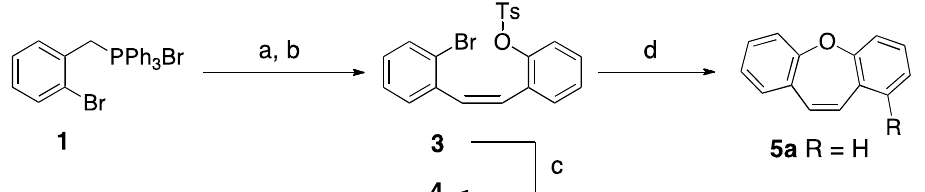
Scheme 2. Synthesis of dibenzoxepin 5a by intramolecular S